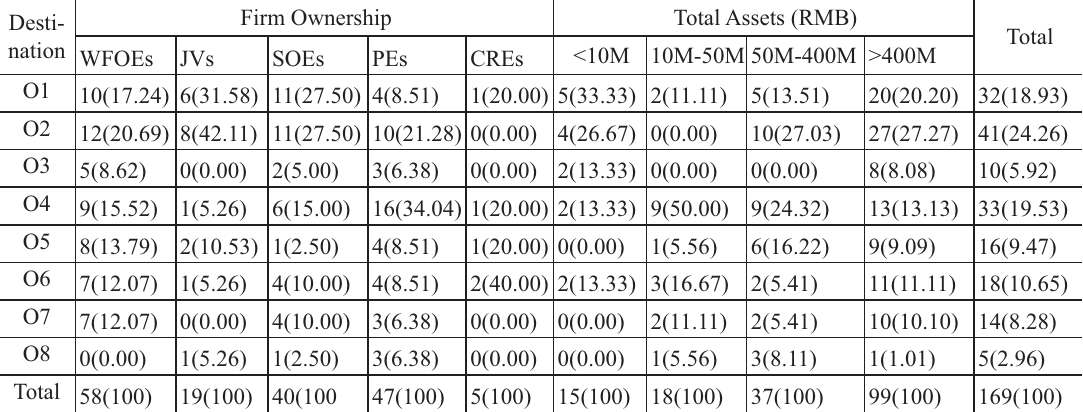
Table 5. Selection of destination for outward FDI